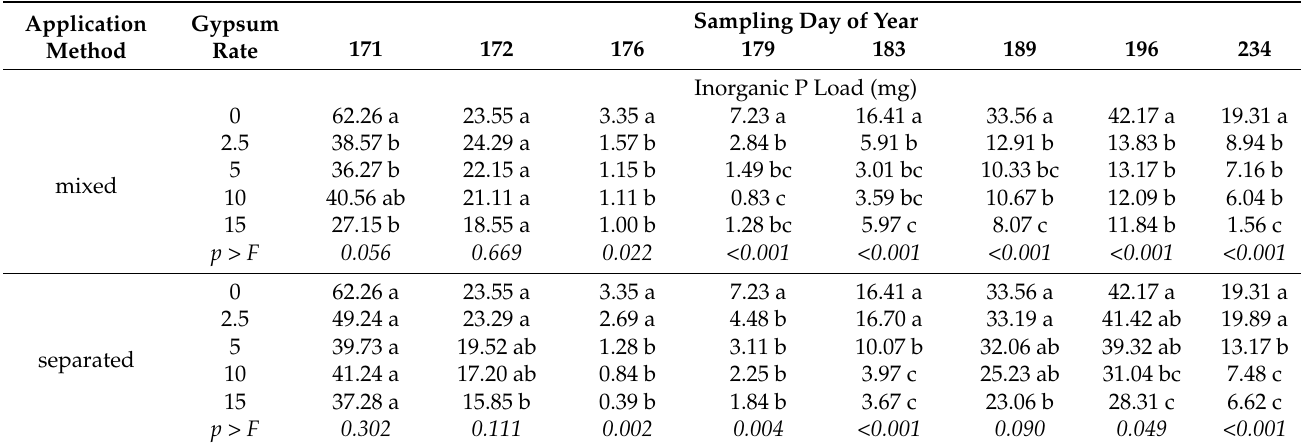
Table 3. Temporal changes in dissolved P leaching load observed over time from containers in 2019 as affected by FGD